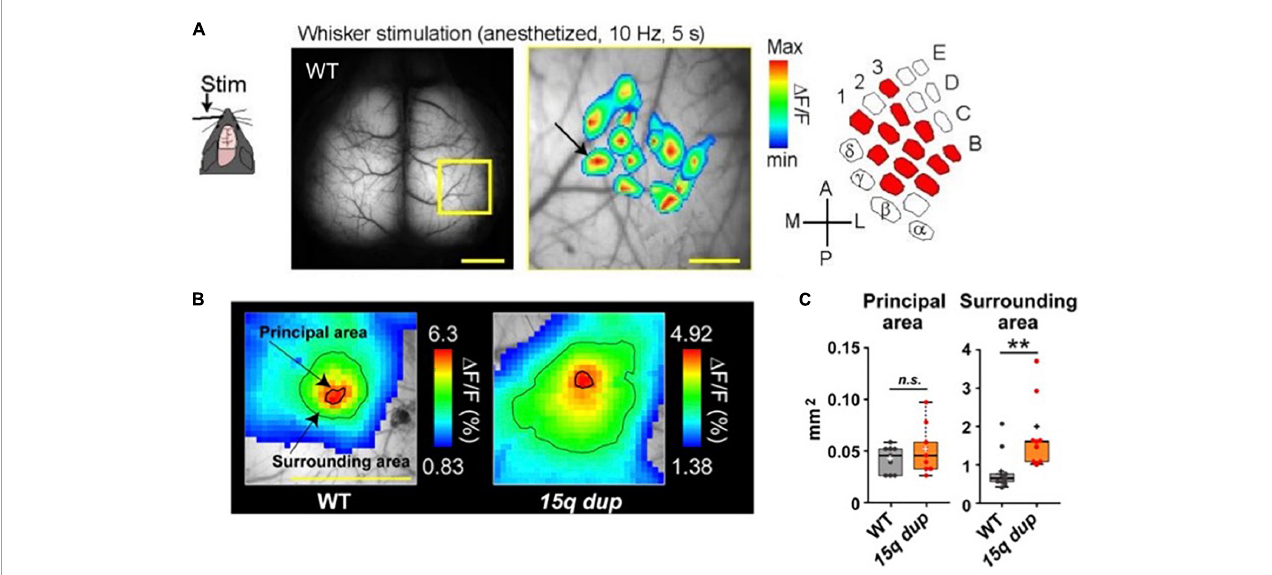
FIGURE5 Examples of cortical whisker-barrel mapping in the WT mouse and autism spectrum disorder (ASD) mouse (15q dup). (A) A single whisker was vibrated for 5 s at 10 Hz. Pseudocolor is the mean of 16 trials and superimposed 12 whisker-barrel maps on one raw image, which is magnified in the yellow square. The drawn map is similar to the classically identified whisker-barrel relationship (right). Scale bar; 1 mm (left), 250 µ m (center). (B) The different whisker-evoked area distribution in WT and 15q dup mouse. The bold line around the red area represents the principal area and a thin line on the green area represents the surrounding area. (C) Comparison of areas between WT and 15q dp. Data are shown in mean ± s. e. m. ** p < 0. 01. [Modified from Monai et al. (2016), Nakai et al.